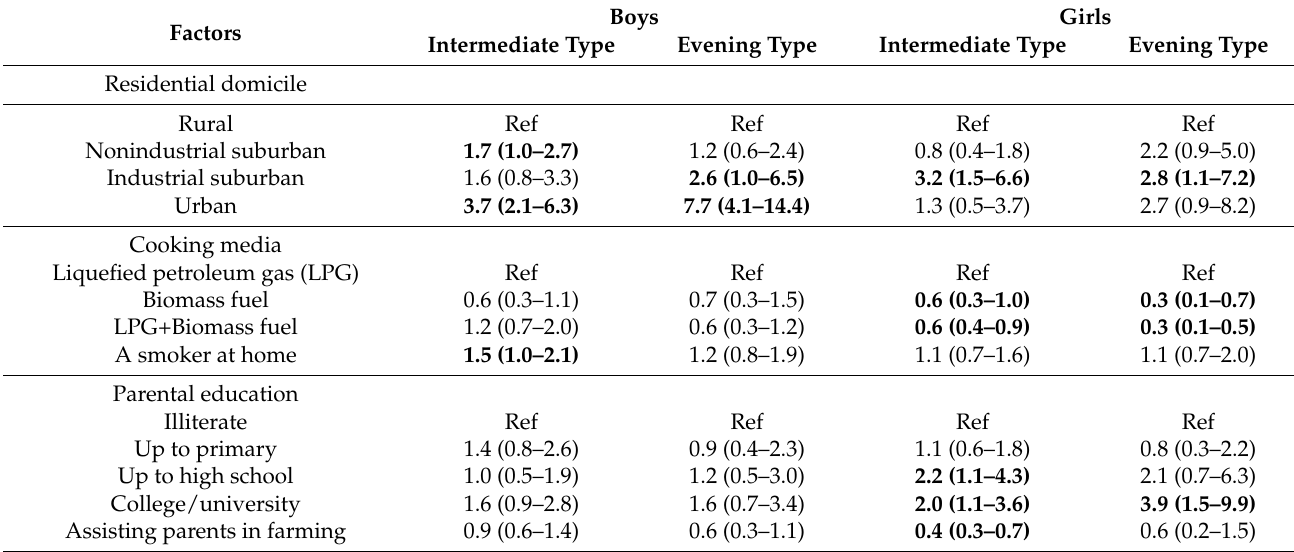
Table 4. Association between living conditions/socioenvironmental factors and chronotype, stratified by sex, considering morning type as the base outcome in a multinomial logistic regression model.